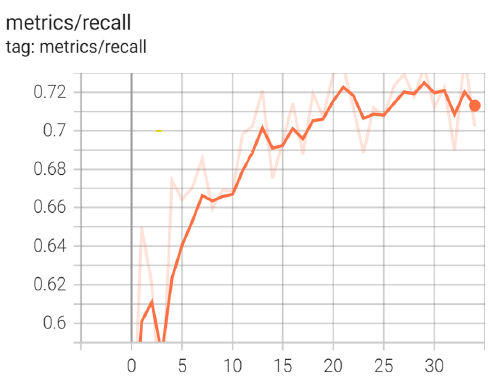
Figure 24. Recall graph YOLOv5: The recall is gradually increasing with the increment of epochs.